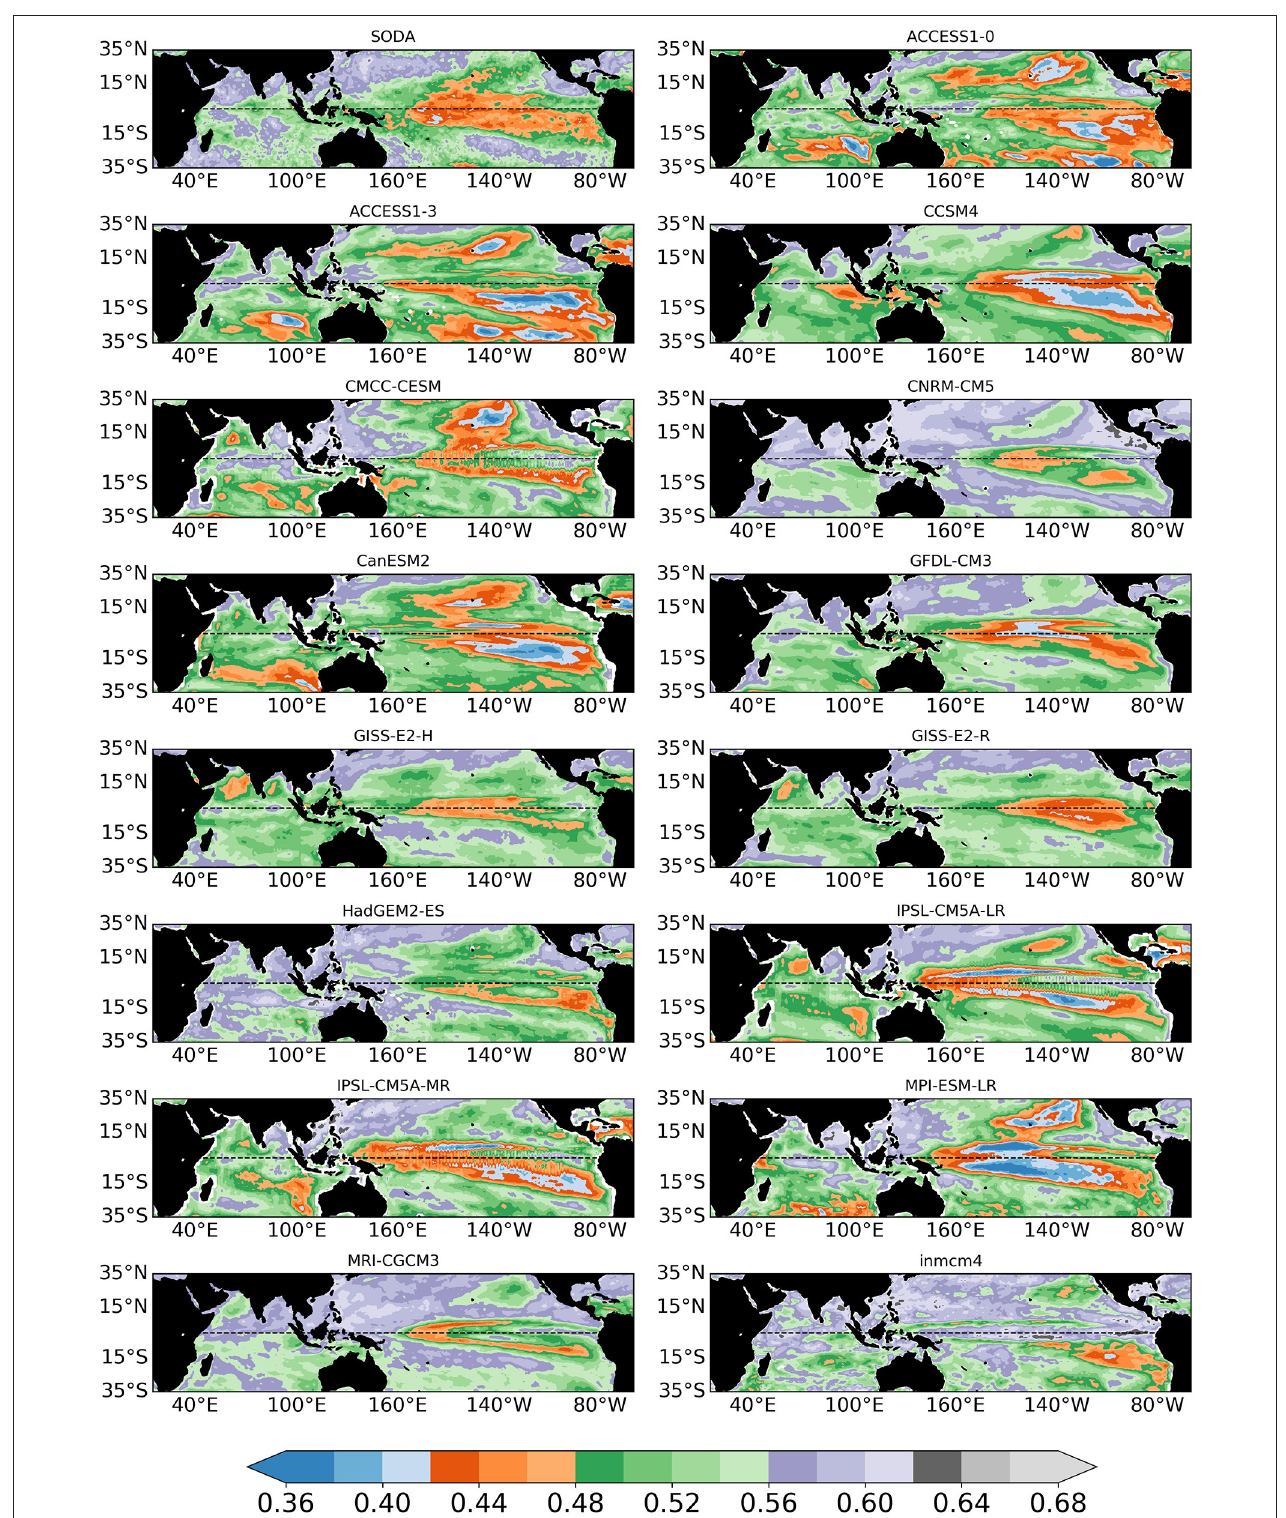
FIGURE 4 | Extended boreal fall (August–September–October–November, ASON) SST entropy fields with microstates M = 3 during 1967–2005 for CMIP5 models and during 1980–2018 for SODA reanalysis.